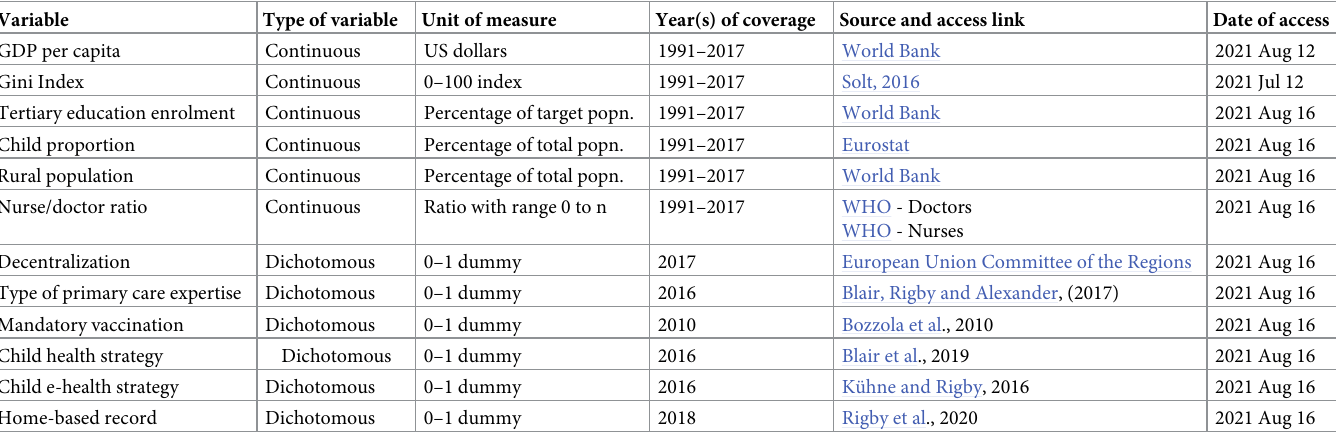
Table 1. Detailed information on data typology, unit of measure, years of coverage, source and date of access. Variable Type of variable Unit of measure Year(s) of coverage Source and access